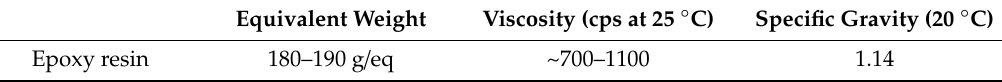
Table 2. The physical characteristics of the epoxy resin.